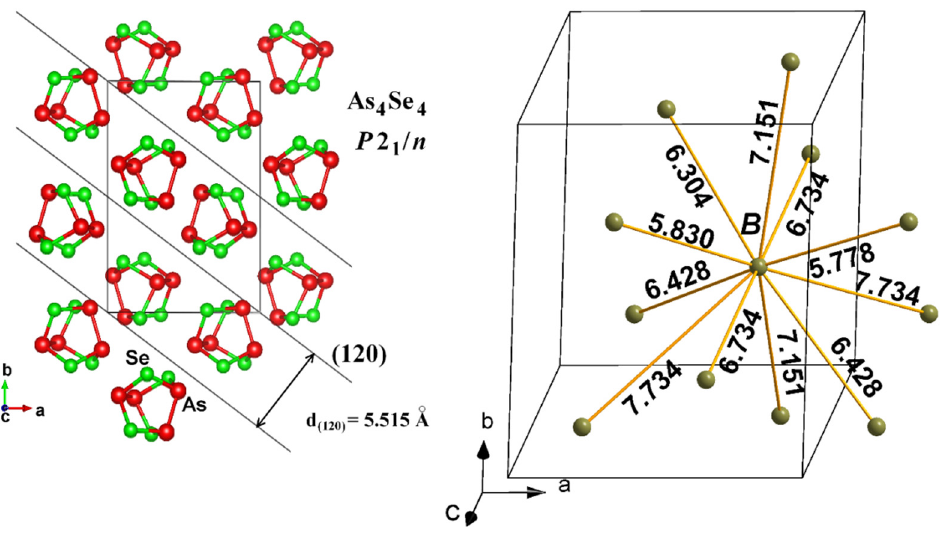
Figure 2. Fragment of crystalline structure of monoclinic As 4 Se 4 reproduced at the basis of experimental data taken from [63] (the space group— P 2 1 / n , the structure type— α -As 4 S 4 , realgar). On the left: packing of As 4 Se 4 cage-like molecules forming a set of (120) crystallographic planes. On the right: all possible centroid-centroid distances B – B (in Å) between “dummy atoms” located at the barycentres of neighboring As 4 Se 4 molecules (see [62] for details of “dummy atoms” identification).